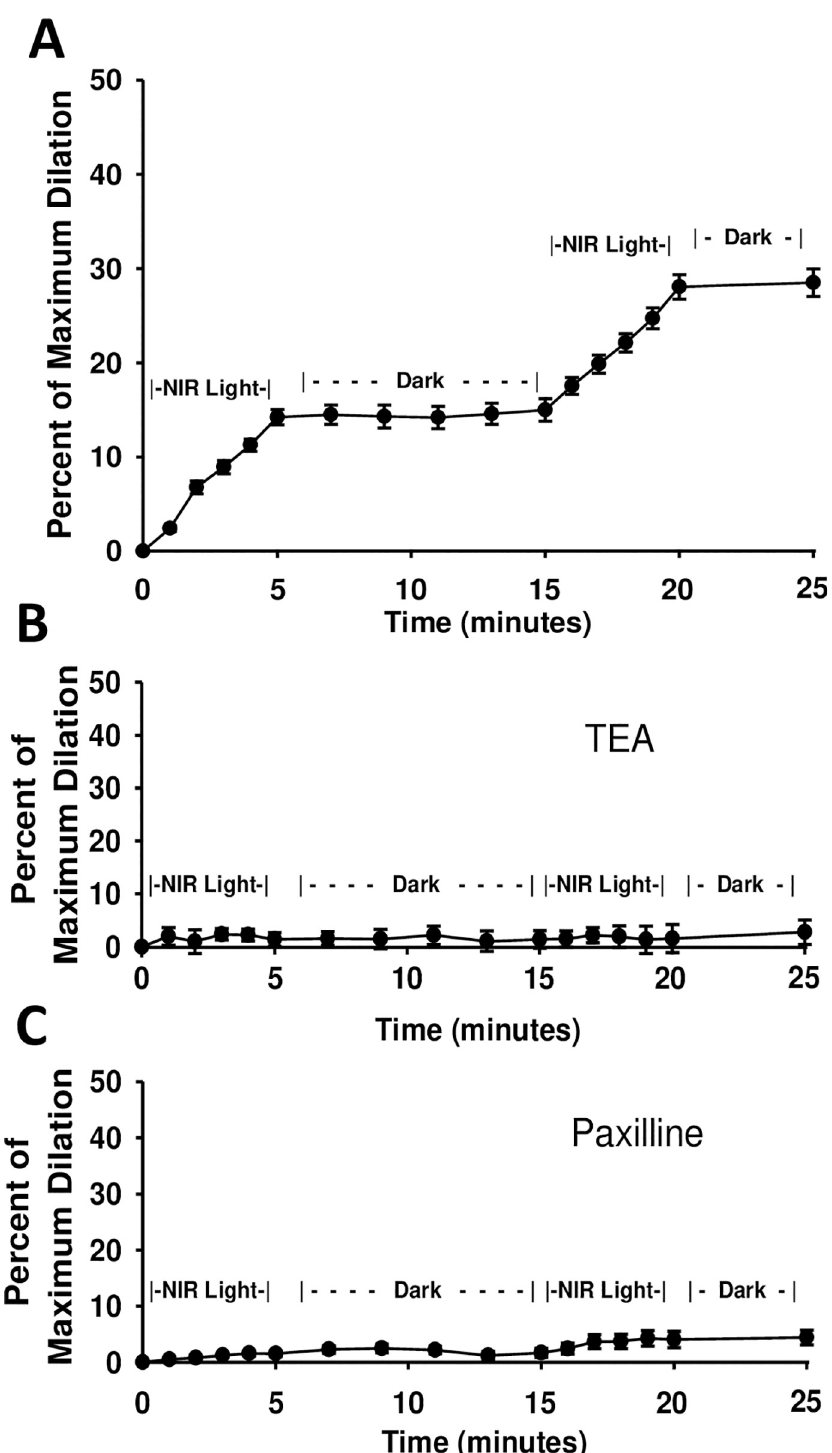
Fig 1. R/NIR stimulates vasodilation and is mediated by potassium channels. Facial arteries from C57BI/6 mice were isolated and pressurized to 60mmHg before pre-constriction with U46619. (A-C) . Vessels were exposed to 5 minutes of 670nm NIR Light, 10 minutes in darkness with no light, and then a second exposure of NIR light. ( B). Preincubation of facial arteries with TEA (1mM for 10min) resulted in no increase in diameter upon energy exposure (R/NIR). ( C). Preincubation of facial arteries with Paxilline (200nM for 15min) resulted in no increase in vessel diameter upon energy exposure (R/NIR). N = 8 vessels from 4 mice in each group. https://doi.org/10.1371/journal.pone.0257896.g001 PLOS ONE | https://doi.org/10.1371/journal.pone.0257896 October 5,